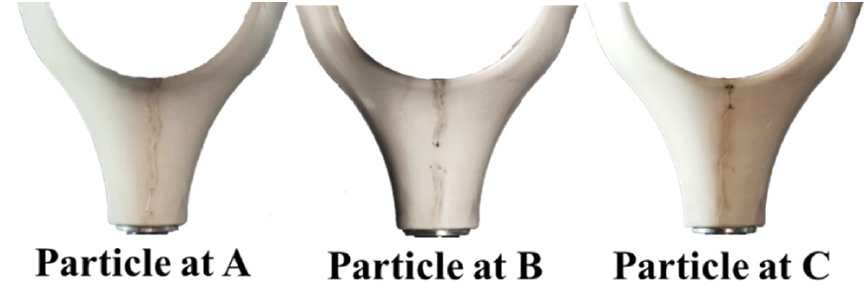
Figure 11. Surface flashover path of tri-post epoxy insulator with metal particles attached.